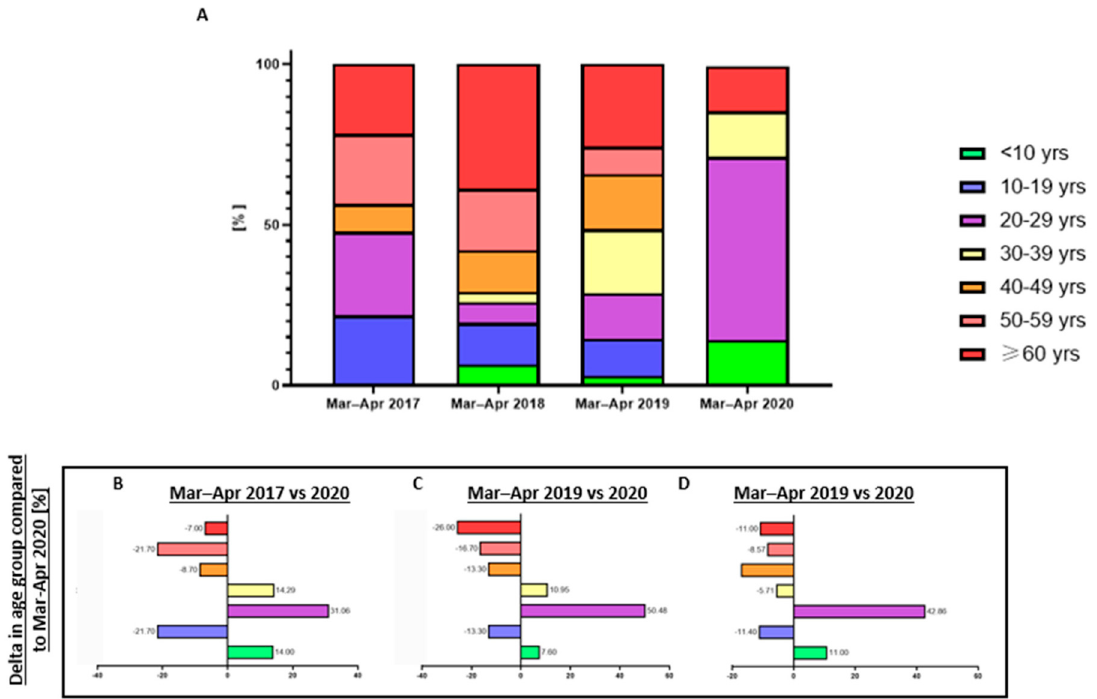
Figure 4. Age distribution across the trauma patients admitted during March and April to the GMC trauma center in the years 2017 – 2020. ( A ) Admissions as the percentage of the total admissions during March and April of each year. ( B – D ) Change in each age group admitted during 2017, 2018, and 2019 compared to the period corresponding to the COVID – 19 lockdown.